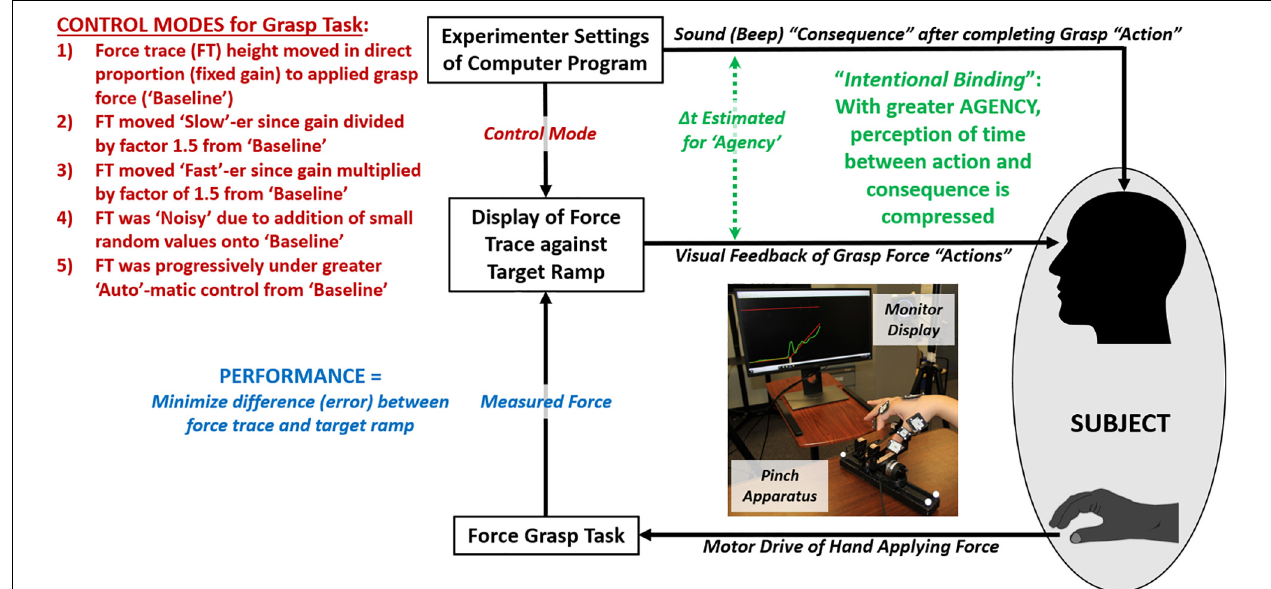
FIGURE 1 | Flow diagram of experiment of participant performing grasp force task to visually trace a target ramp under varying control modes while assessing performance and agency.